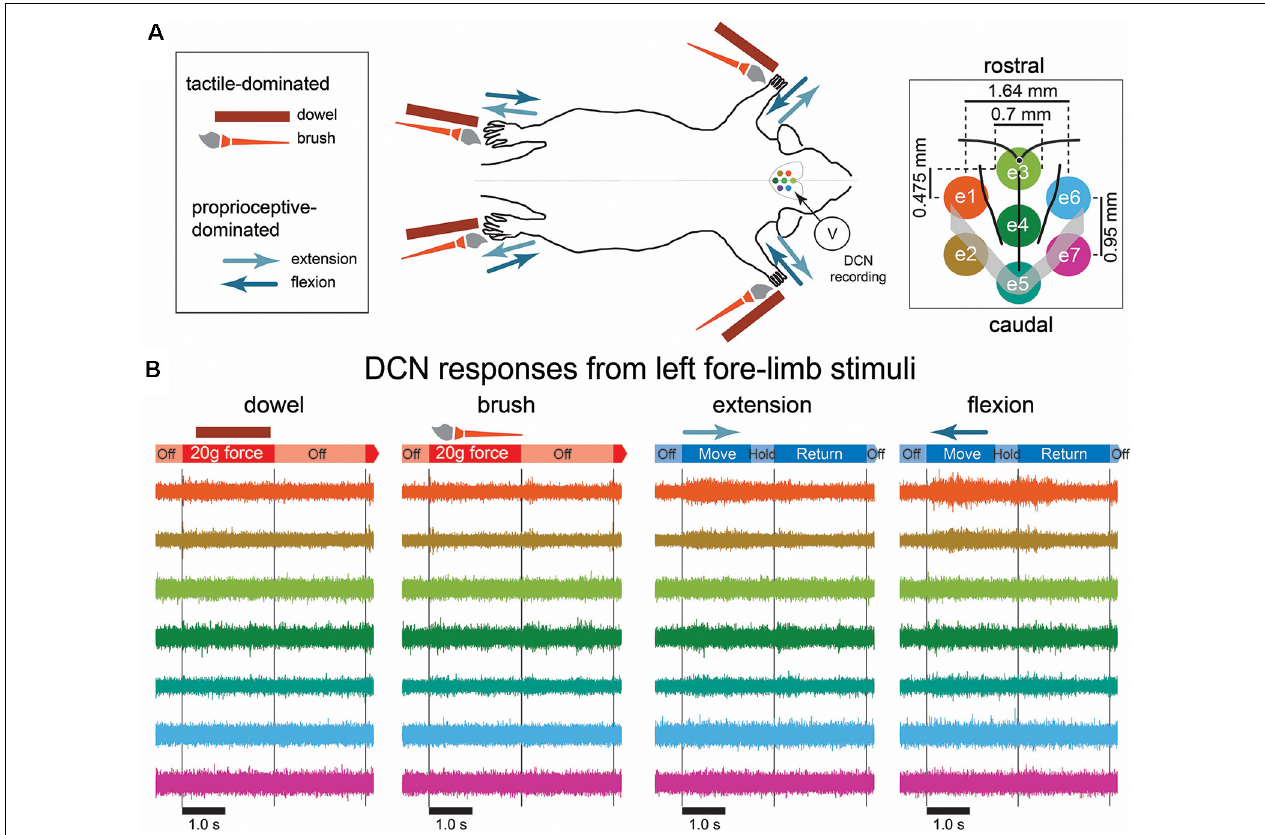
FIGURE 1 | Mechanical stimulation conditions, recording arrangement, and example signals recorded from the dorsal column nuclei (DCN). (A) A schematic diagram of the mechanical stimulation and surface array recording paradigm. Each of the four limbs was individually stimulated with a mechanical stimulus as shown in the left insert, amounting to 16 possible combinations of stimulus type and location. The two possible tactile-dominated stimuli comprised a phase that applied a 20-g force with a dowel or a brush to the palmar or plantar surface; the two possible proprioceptive-dominated stimuli applied extension or flexion to one of the limbs which included move , hold , and return phases. Dorsal column nuclei signals were simultaneously recorded from seven electrodes of a surface multi-electrode array (right insert). (B) Examples of 5 s of DCN signal recordings in response to stimulation of the left forelimb with each of the four stimulus types. Signals are color-coded according to their corresponding recording electrode shown in the right insert of (A) . The timing of stimulus phases is shown below each signal example for each stimulus type. Gray lines indicate the start and end of stimulus-on/-off periods. Abbreviations: DCN, dorsal column nuclei; e1, electrode 1; e2, electrode 2;